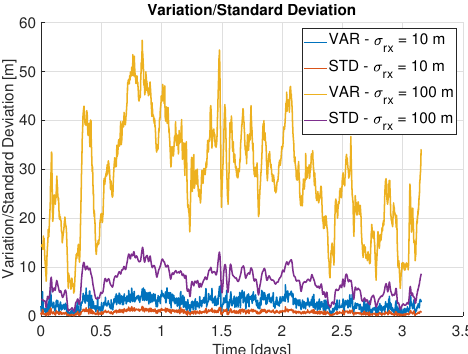
Figure 9. Variation in the terrain along the traverse of the rover considering both the standard deviation (STD) and the absolute deviation (VAR) and considering a rover horizontal uncertainty of both 10 m and 100